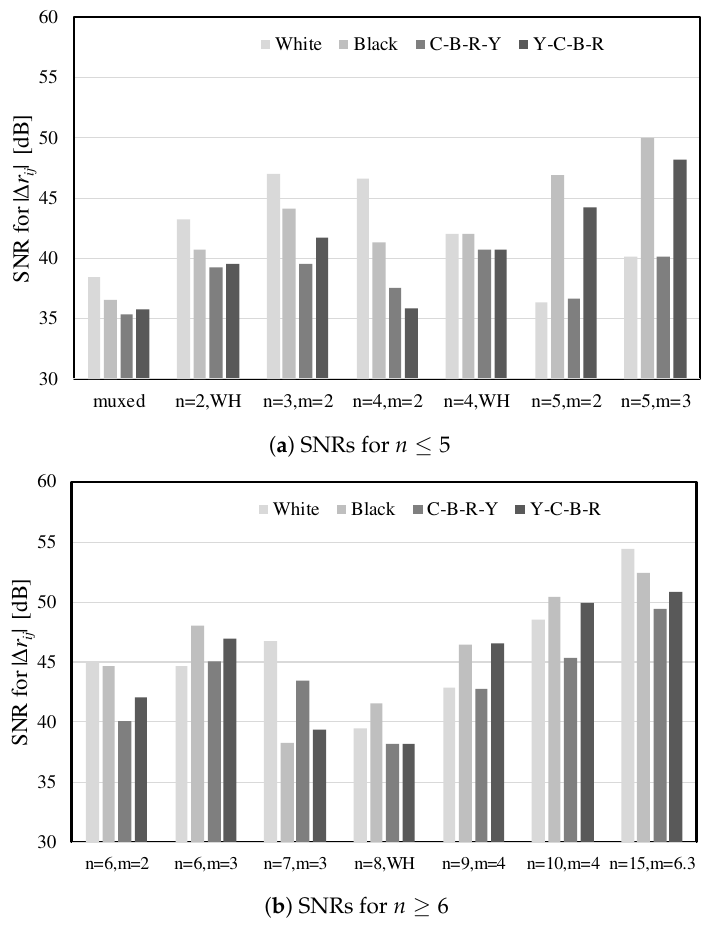
Figure 13. Effects on the SNRs of received signals for the existence of different display